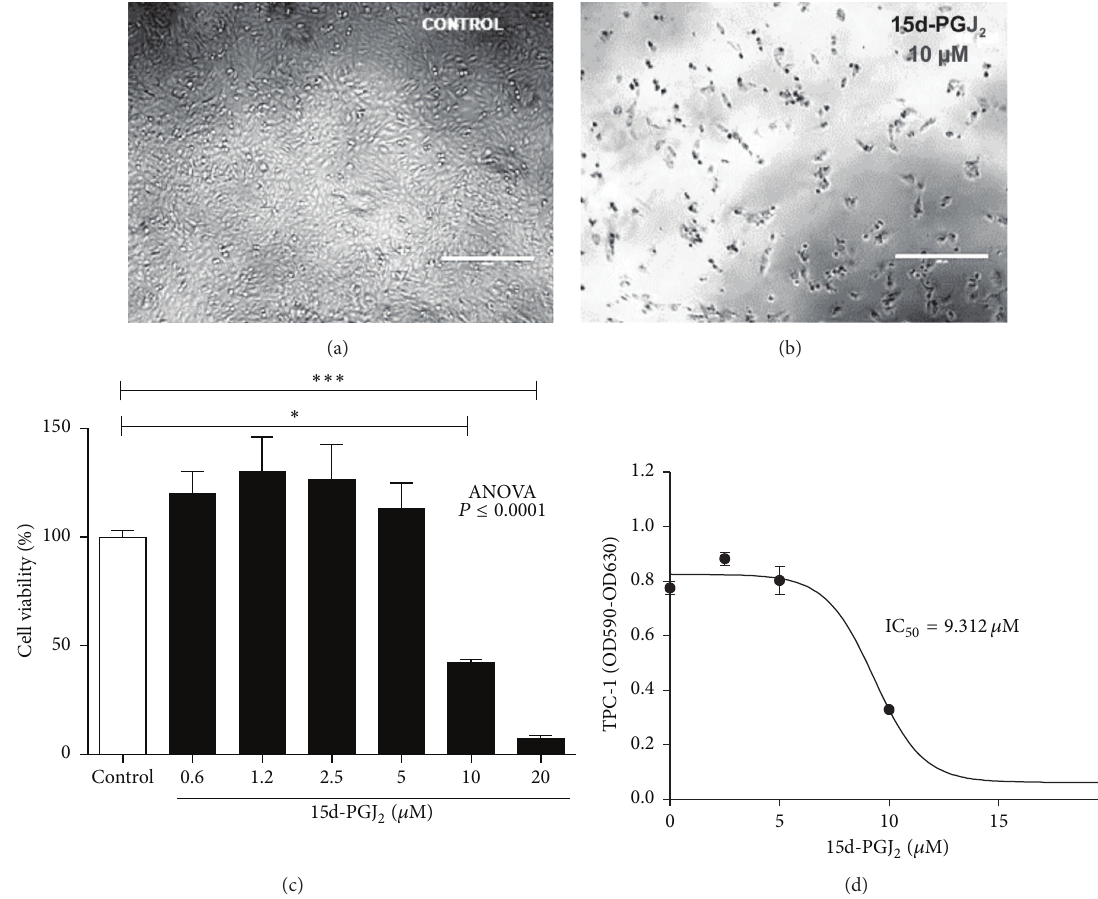
Figure 1: 15d-PGJ 2 decreased the viability of TPC-1cells. TPC-1cells were treated with 15d-PGJ 2 . (a) represents the cell culture without treatment. (b) Cells treated with 10 𝜇 M of 15d-PGJ 2 . (c) Viability of the TPC-1cells treated with 15d-PGJ 2 in the concentrations of 0 to 20 𝜇 M. (d) IC 50 from cell viability following treatment with 15d-PGJ 2 . The data are presented as means ± standard deviation of three replicates from at least three independent tests. An asterisk ∗ indicates statistically significant difference from the control ( ∗ 𝑃 > 0.01 ; ∗∗∗ 𝑃 > 0.001